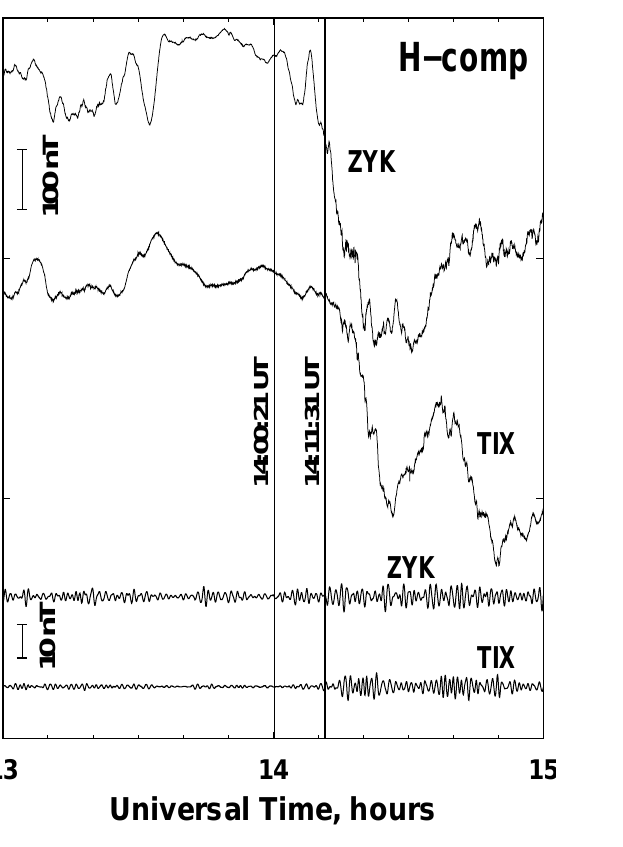
Fig. 7. One-second ground magnetometer data from the ZYK and TIX stations in the 210MM array.